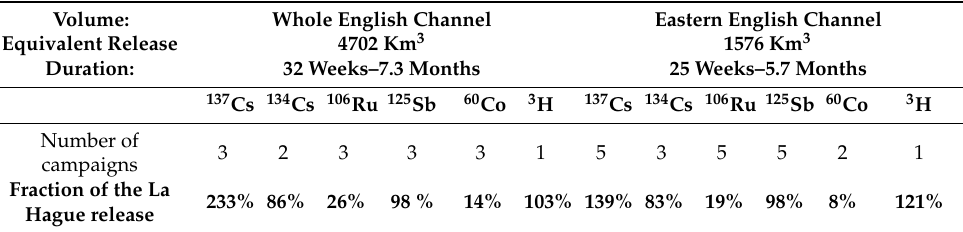
Table 3. Comparison of measured quantities of radioactivity in the English Channel with correspondent releases from La Hague from 1983 to 1994, adapted from [20]. Antimony-125 is used as reference for the calculation; the background concentrations in Atlantic surface waters ( 137 Cs, 3 H) and Chernobyl fallout ( 137 Cs, 134 Cs) has been deduced.